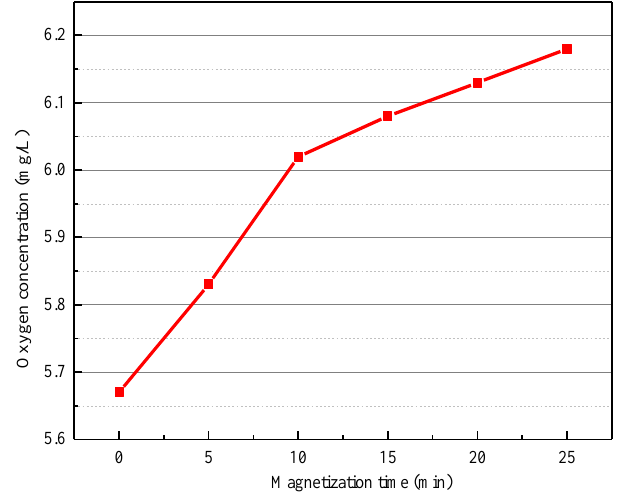
Figure 10. The relationship between oxygen concentration and magnetization time.